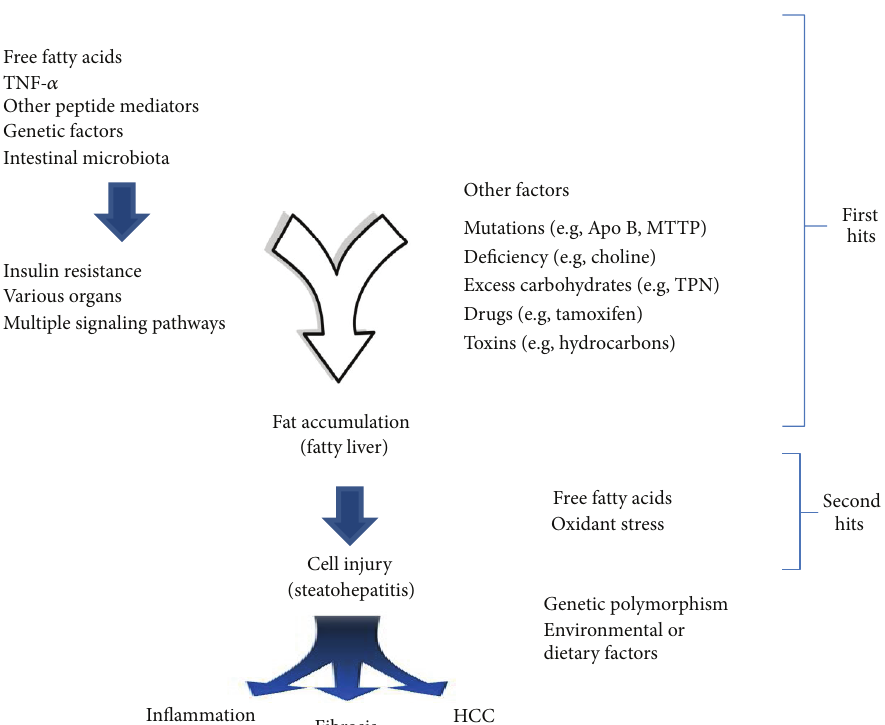
[5]. Male patients had significantly higher rates of NAFLD (58.9%) and NASH (65%). Limitations of this study included a possible selection